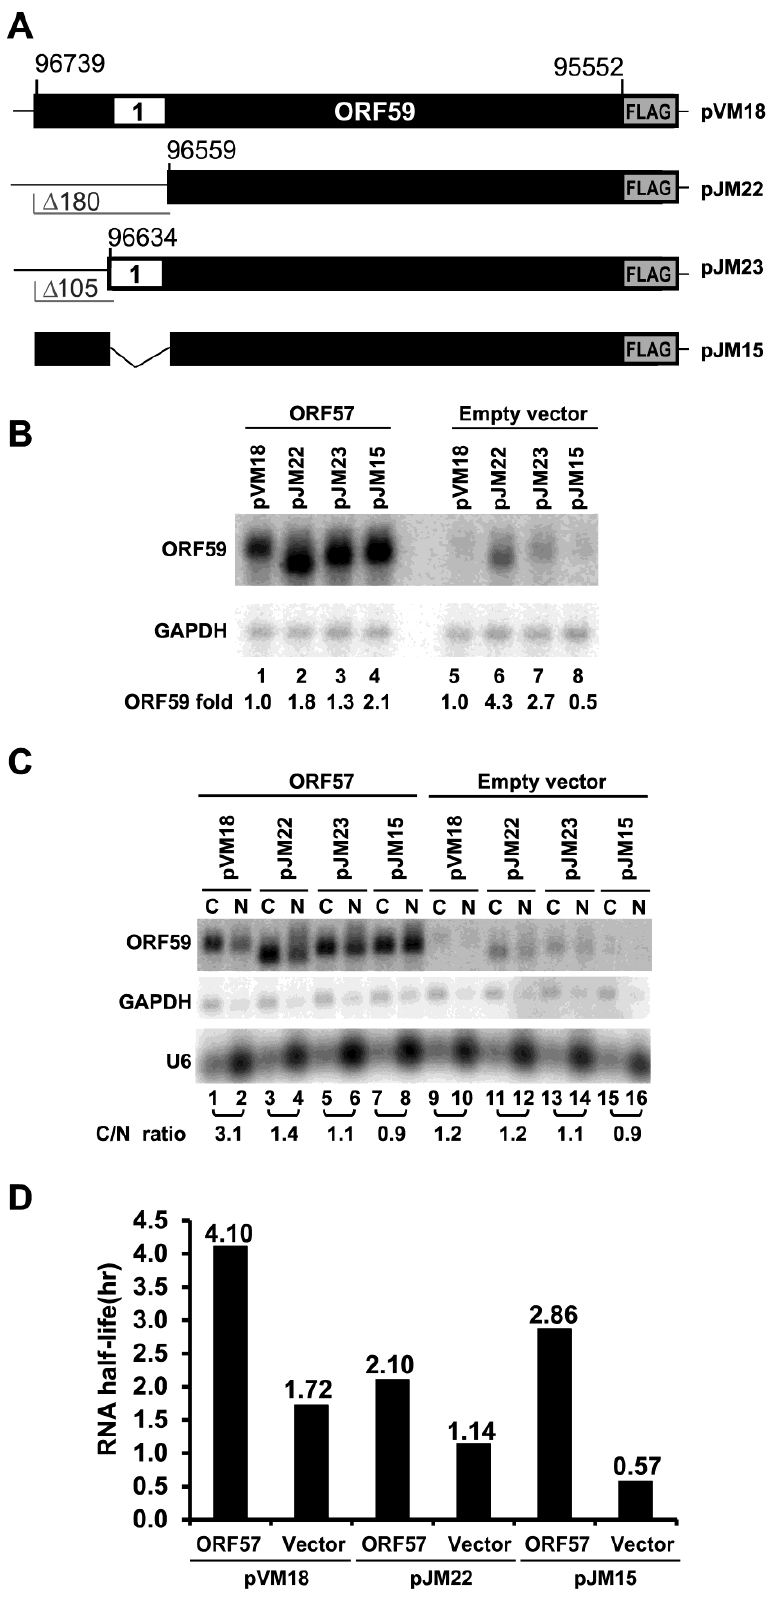
Figure 3. The role of 5’ ORF59 MRE in ORF59 RNA export and half-life. ( A ) Diagrams of wt ORF59 and its 5’ in-frame deletion mutants. See other details in Figure 1. ( B ) Expression of ORF59 RNA in HEK293 cells. Total RNA from HEK293 cells transfected with individual ORF59 construct in the presence or absence (empty vector) of ORF57-FLAG was